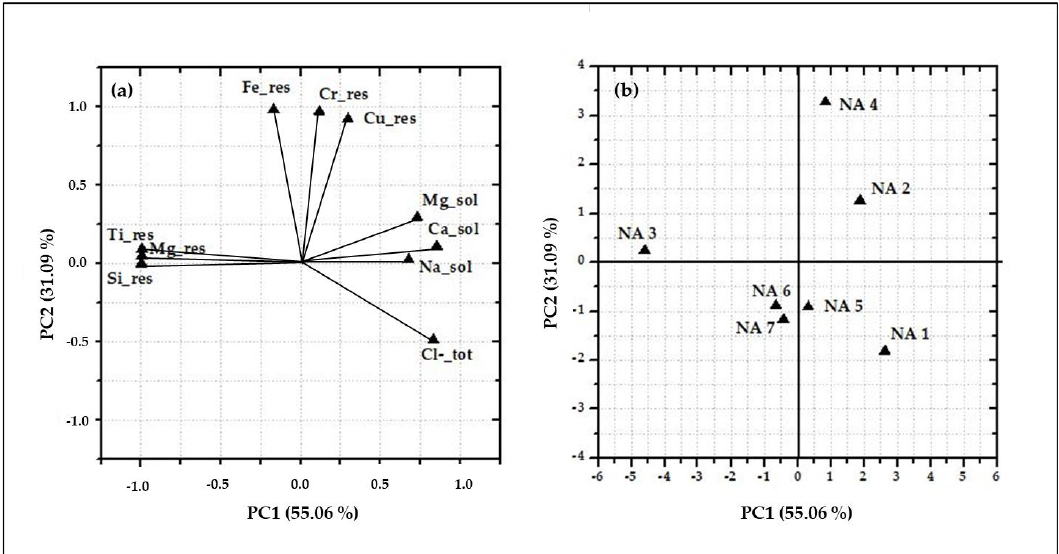
Figure 5. Biplots of the factor coordinates ( a ) and of factor scores ( b ) of the first two principal components (PCs) obtained by correlation-based principal component analysis (PCA) of the concentrations per unit leaf area in the water-soluble fraction of Ca, Mg, Na, Cl and in the insoluble fraction of Cr, Cu, Fe, Mg, Si and Ti, detected at the seven sampling sites within the urban forest in Naples.